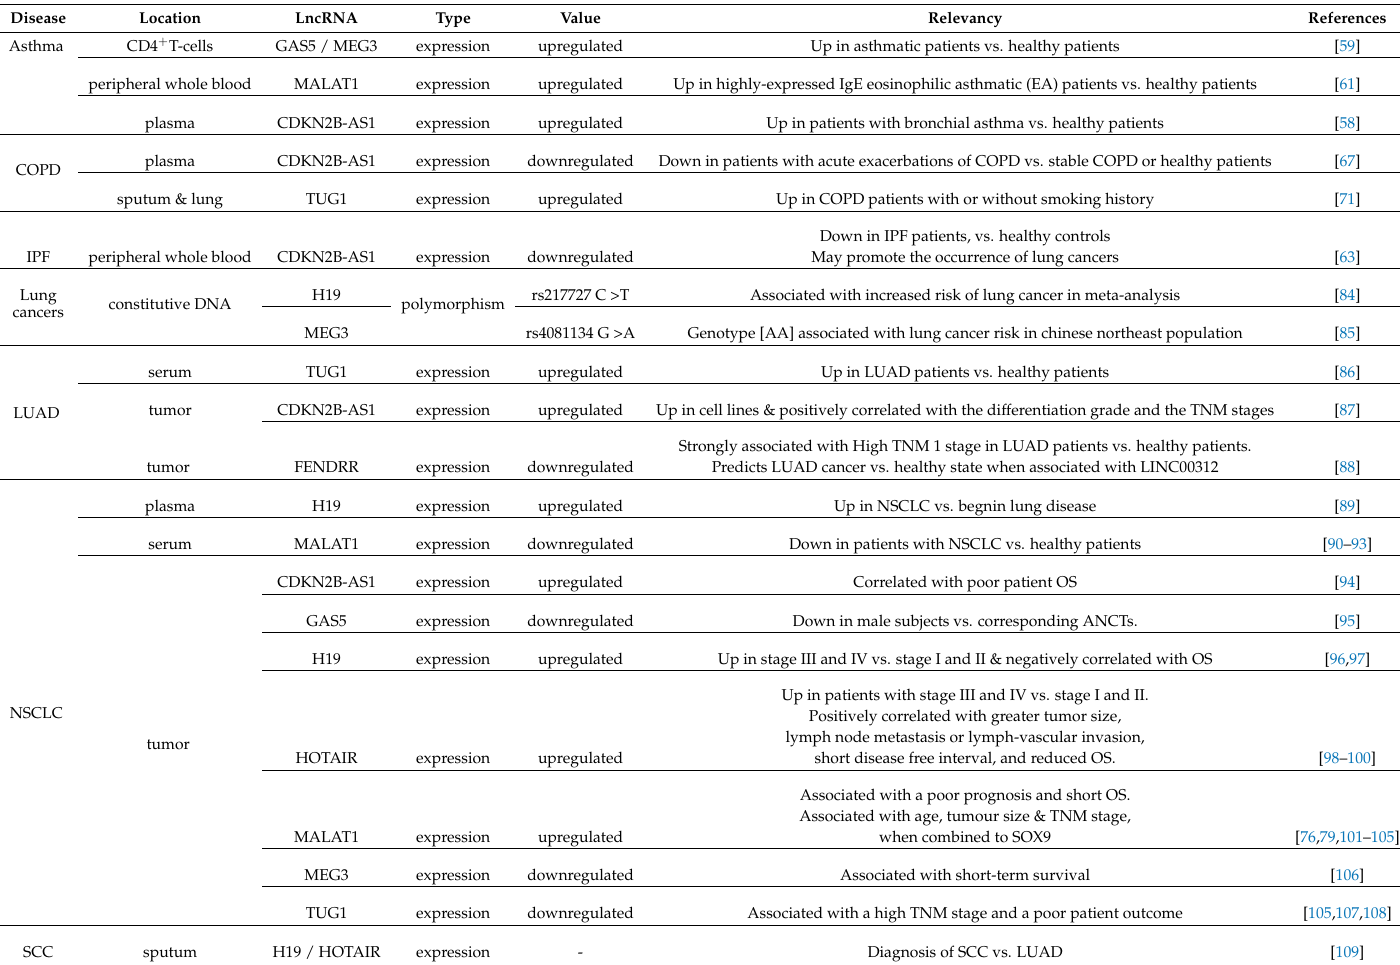
Table 2. Potential biomarkers from the eight lncRNAs observed in lung